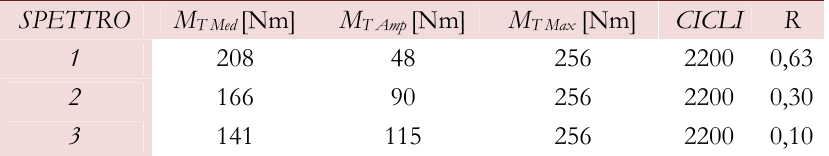
Tabella 9: Set di carichi derivati dallo spettro n° 1 del set precedente mantenendo invariate coppia massima